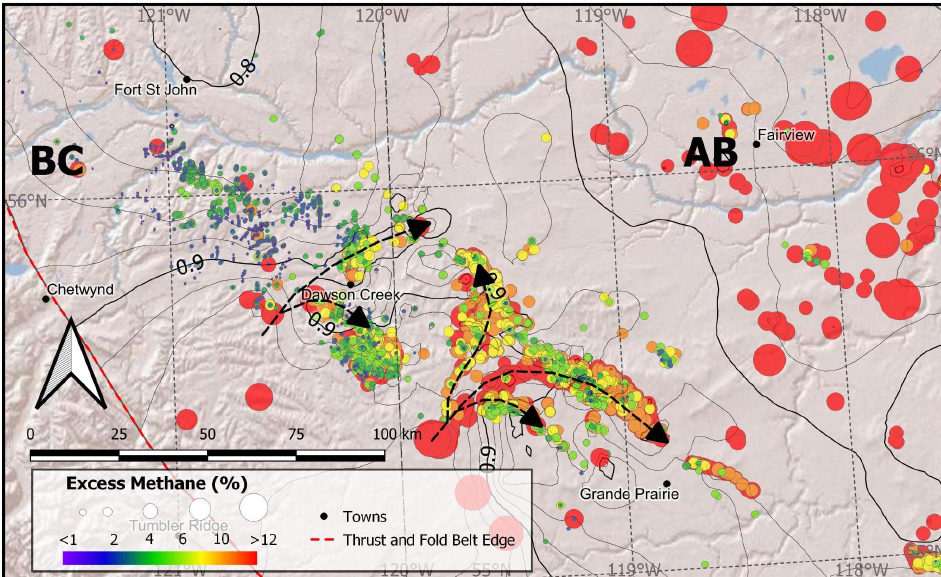
Figure 39. Expanded view of the Fort St. John to Grand Prairie areas that are the focus of the [2] and [4] studies. Black dashed lines with arrows indicate the direction of more mature, drier gas (higher methane content) having migrated updip from the BC/Alberta boundary into less mature, more liquid-rich sections of the Montney Alberta play area. See Figure 38 for the scale and legend.